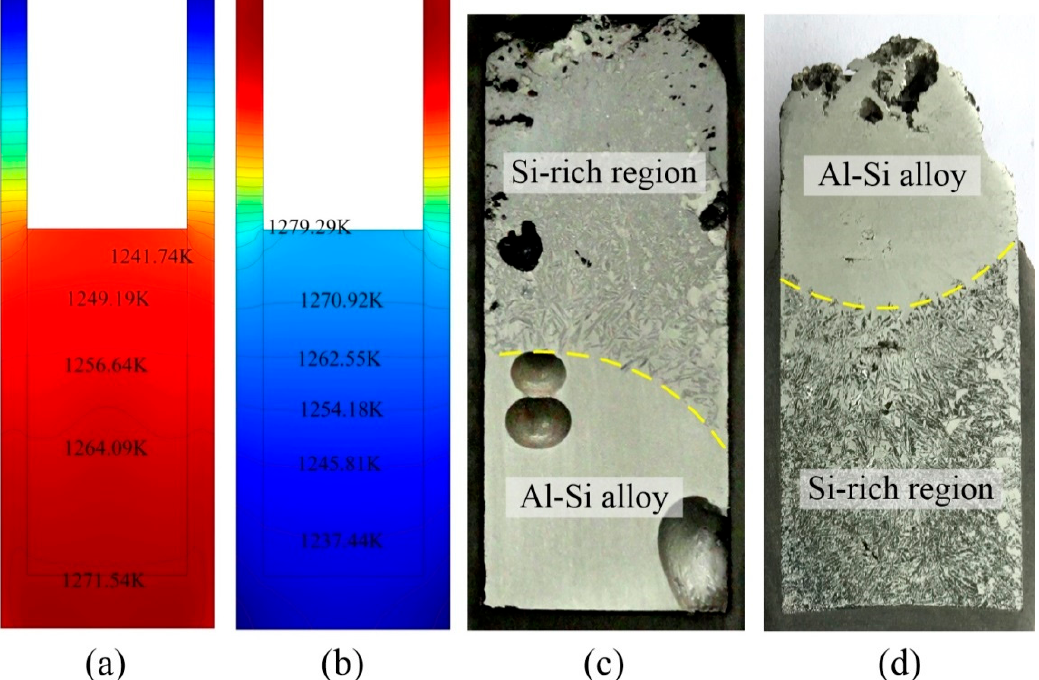
Figure 5. ( a ) Temperature distribution of the sample when pulling up, ( b ) temperature distribution of the sample when pulling down, ( c ) cross-section of the solidified sample when pulling up, and ( d ) cross-section of the solidified sample when pulling down.